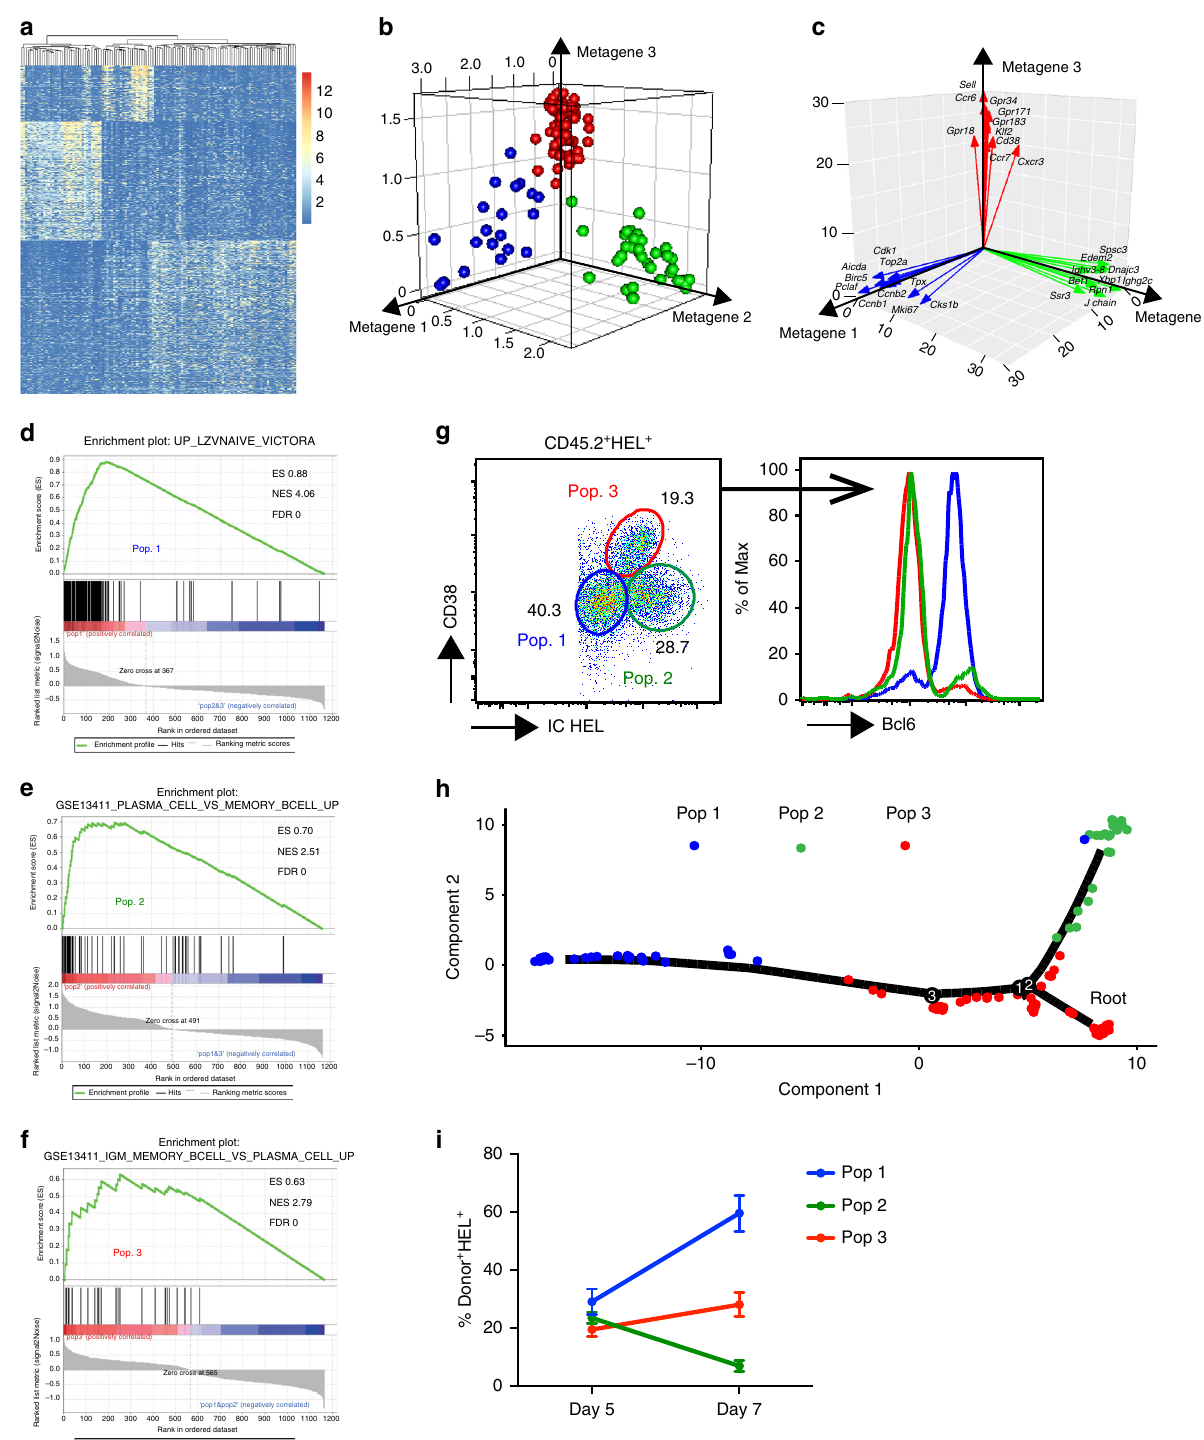
Fig. 6 Deconvolution of the secondary antibody response by single-cell RNA sequencing. a Heatmap showing 8190 differentially expressed genes from 122 single SW HEL donor-derived B cells. b Deconvolution of 122 single cells into three populations by expression of metagenes 1, 2 and 3 by NMF. c Vector diagram showing individual gene contributions to the metagenes 1, 2 and 3. d GSEA identi fi es population 1 as GC. e GSEA identi fi es population 2 as plasma cell. f GSEA identi fi es population 3 as MBCs. g Flow cytometric analysis of donor-derived HEL-binding B cells 4 days after HEL-OVA re-immunisation showing CD38, intracellular (IC) HEL-binding immunoglobulin and Bcl-6 expression on the 3 populations. h Pseudotime analysis of single-cell RNA sequencing data. i Proportion of 3 populations by fl ow cytometric analysis of donor-derived HEL-binding B cells 5 and 7 days after HEL-OVA re- immunisation. Data are representative of two independent experiments with 5 mice per time